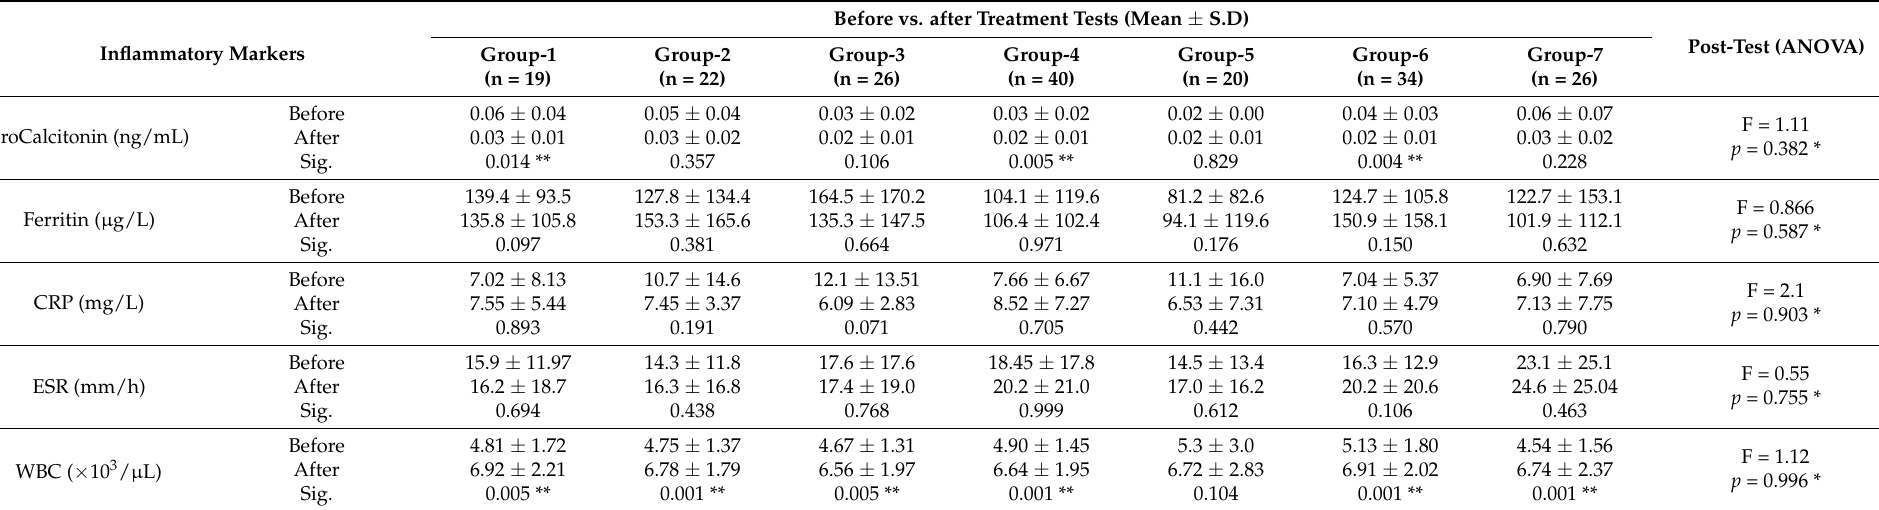
Table 3. Comparison of mean levels of inflammatory markers between groups.